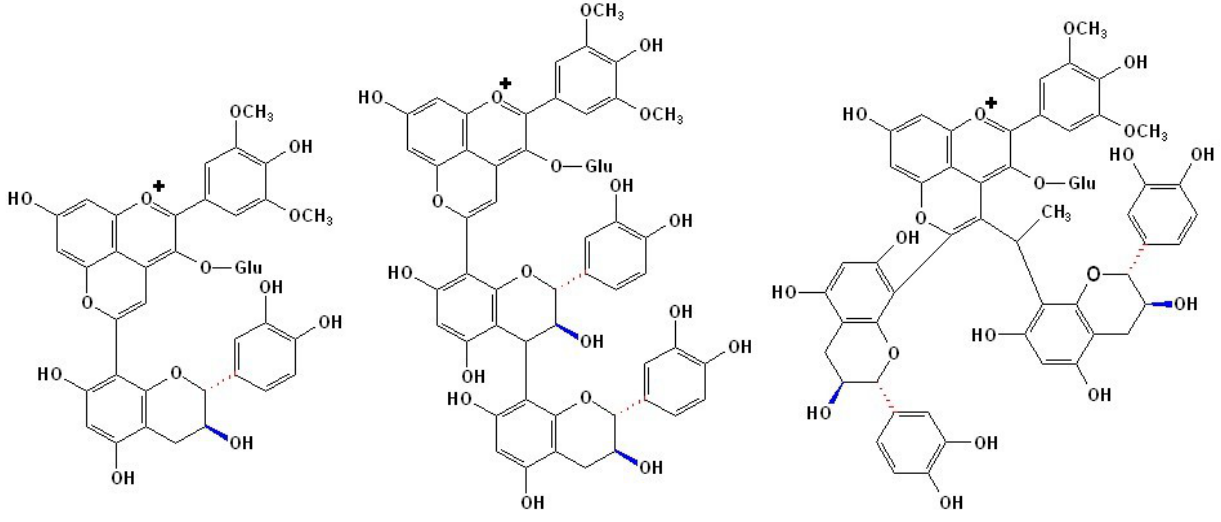
Figure 4. The structures of flavanyl-pyranoanthocyanins generated from malvidin-3- O